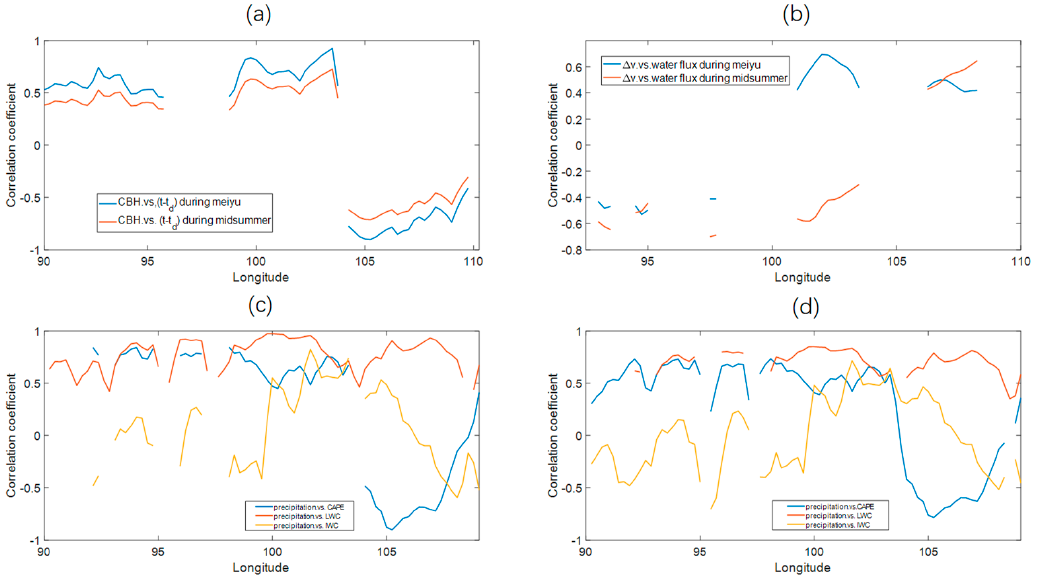
12 of 17 Table 2. Comparison of cloud base height (CBH) from ERA5 dataset and lifting condensation level (LCL) above ground level (AGL) during summer over the Tibetan Plateau (TP) and Sichuan Basin